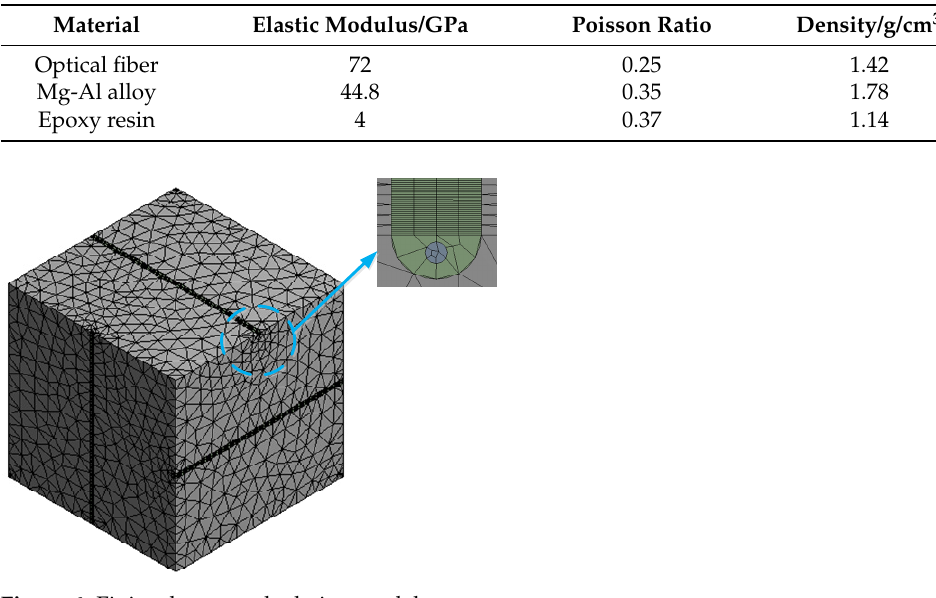
Figure 8. The variation of FBG strain with X -axis